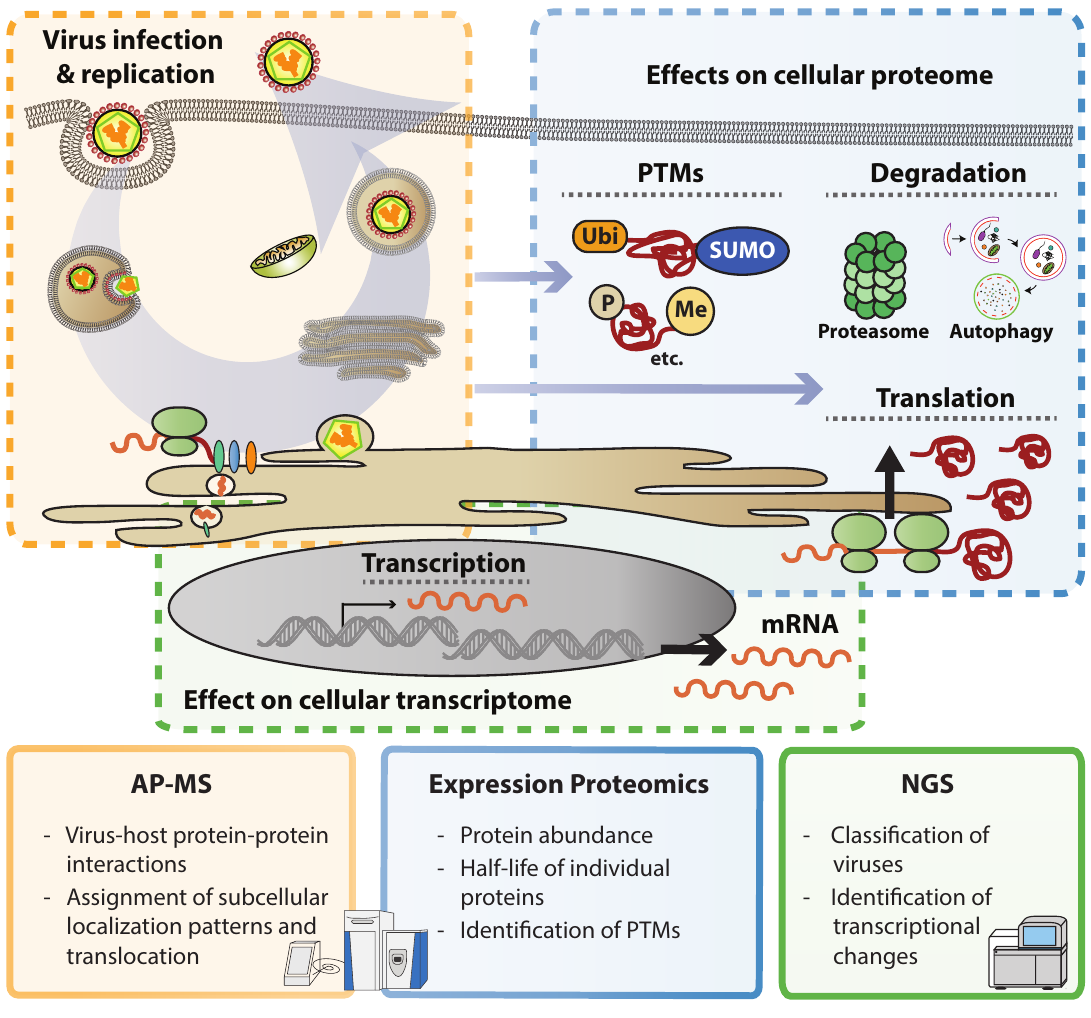
Figure 1. – Omics methods to study virus-induced cellular perturbations. The key advantages of Interaction proteomics (a ffi nity purification mass spectrometry, AP-MS), expression proteomics and next generation sequencing (NGS) in studying flavivirus-induced perturbations are listed within each square. Colors indicate the respective step(s) of the viral replication cycles predominantly targeted by each method. Abbreviations: PTMs, post-translational